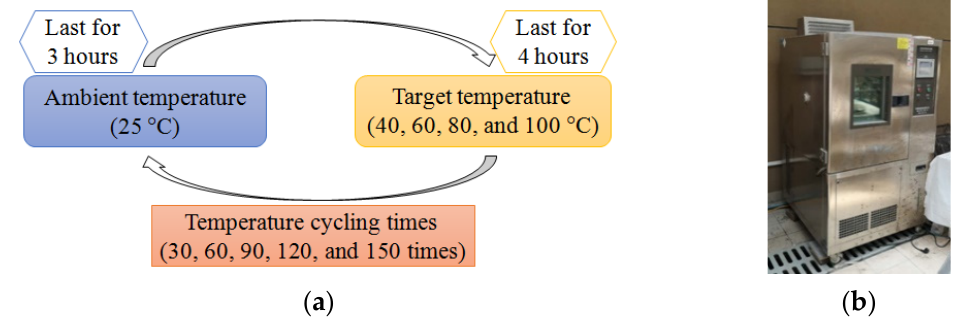
Figure 2. Simulation of daily temperature variations: ( a ) cyclic temperature regime; ( b ) programmable environmental chamber (Adapted from Ref. [32]).